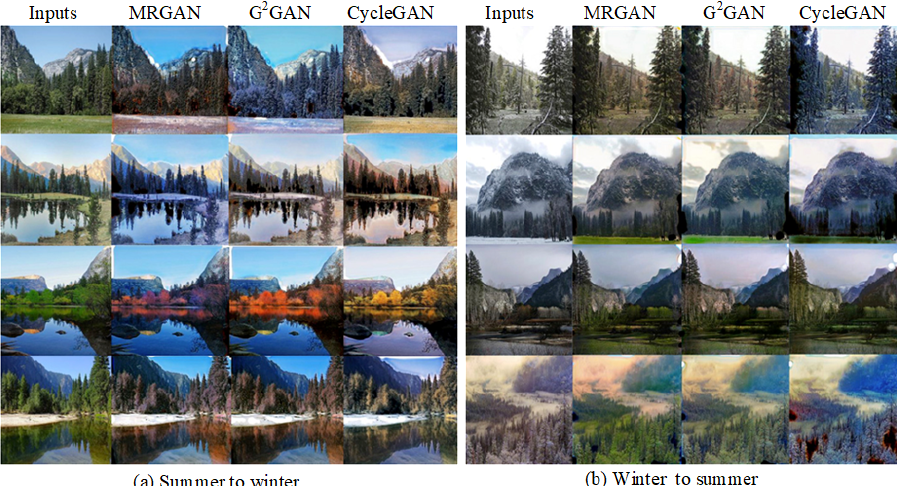
Figure 5. The experimental results on summer 2 winter for season conversion using MRGAN, G 2 GAN and CycleGAN. ( a ) The result images from summer to winter. ( b ) The result images from winter to summer.